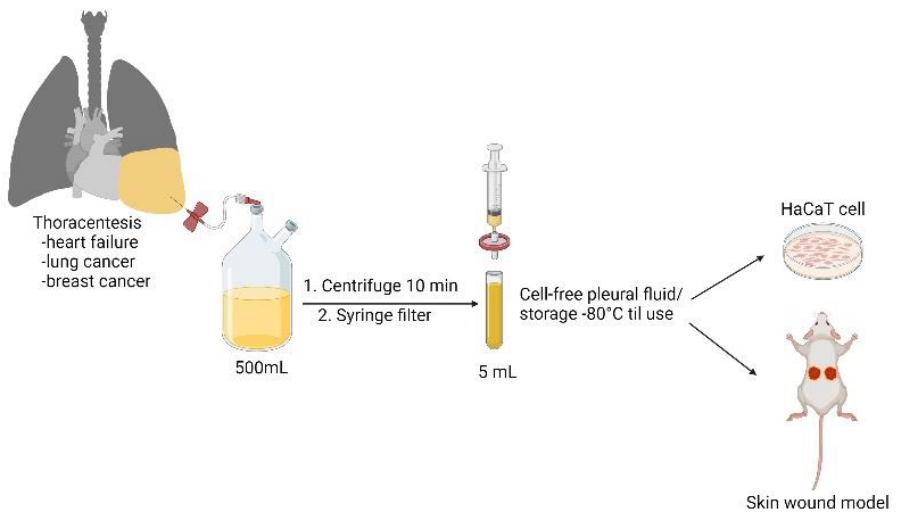
Figure 1. Preparation protocol of cell-free pleural fluid.